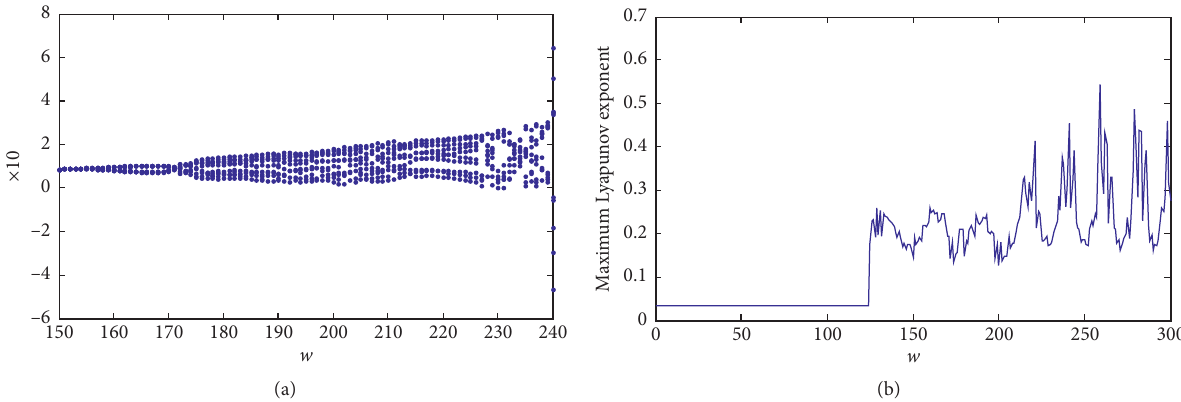
Figure 30: (a) Vibrational bifurcation diagram with the Coulomb model when t ∈ 0 . 0581 0 . 1009 􏼂 􏼃 . (b) Maximum Lyapunov exponent curve with the Coulomb model when t ∈ 0 . 0581 0 . 1009 􏼂 􏼃 .